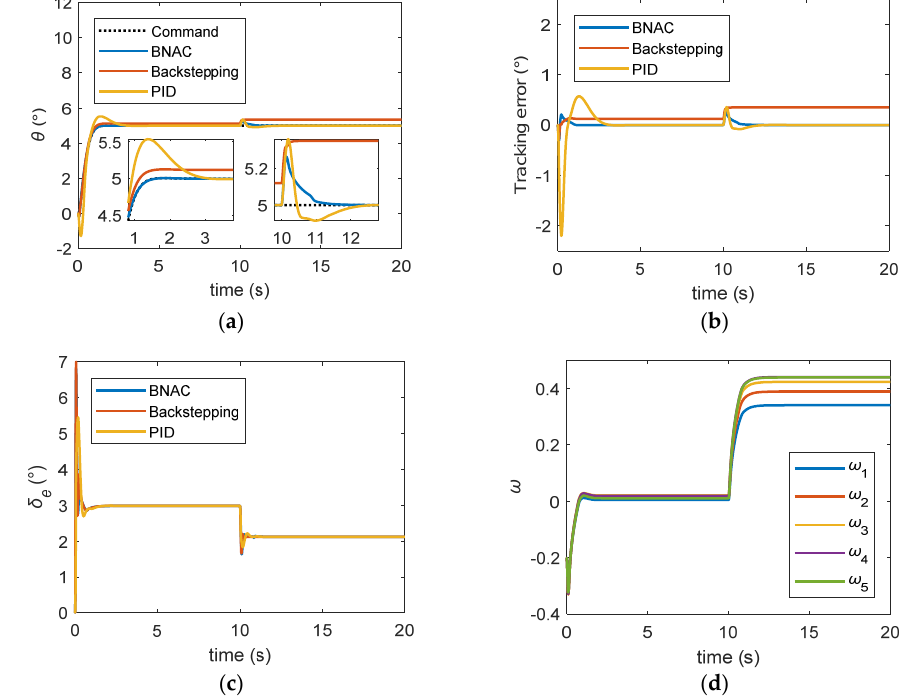
Figure 10. Step signal tracking results under external disturbance and parametric uncertainties: ( a ) pitch angle trajectory; ( b ) tracking error; ( c ) elevator deflection; ( d ) RBF NN